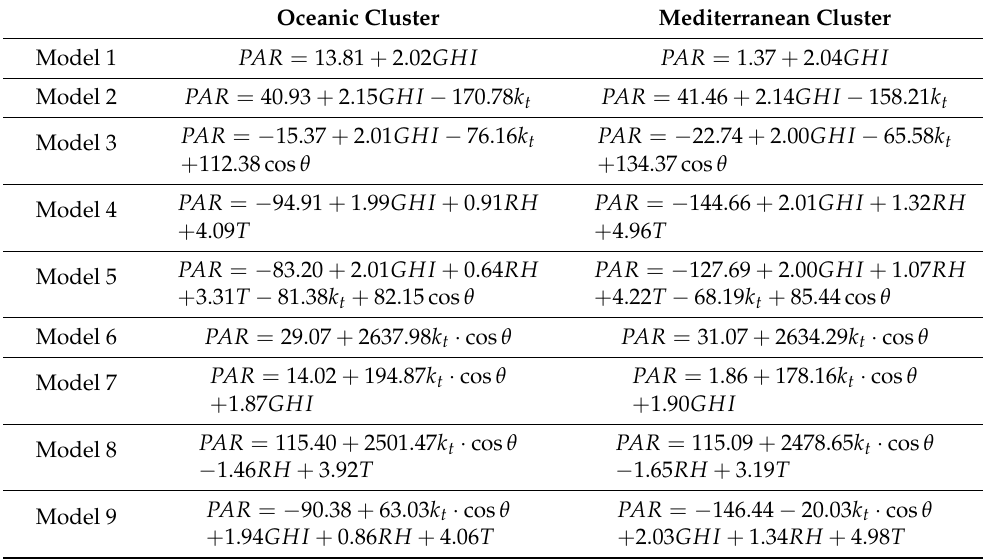
Table 3. Equations of the nine models for each region. Oceanic Cluster Mediterranean Cluster Model